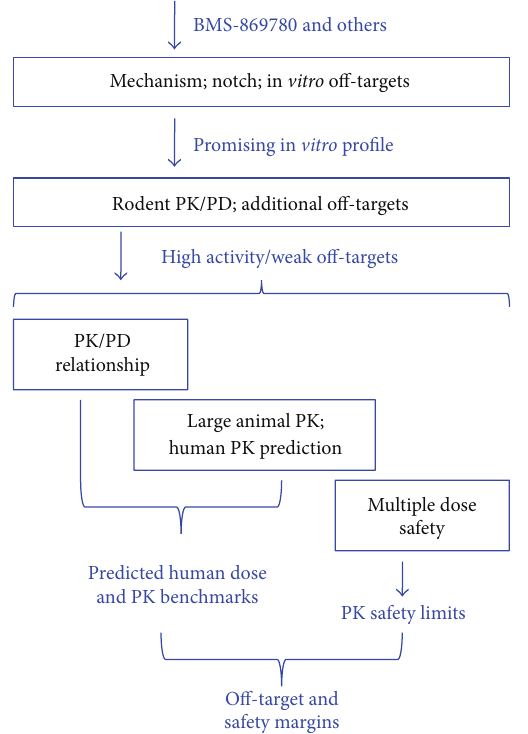
Figure 11: An overview of the characterization of BMS-869780 illustrates only the key steps in integration of data. Additional off- target and pharmaceutics evaluations necessary for decisions on individual compounds are not represented in this